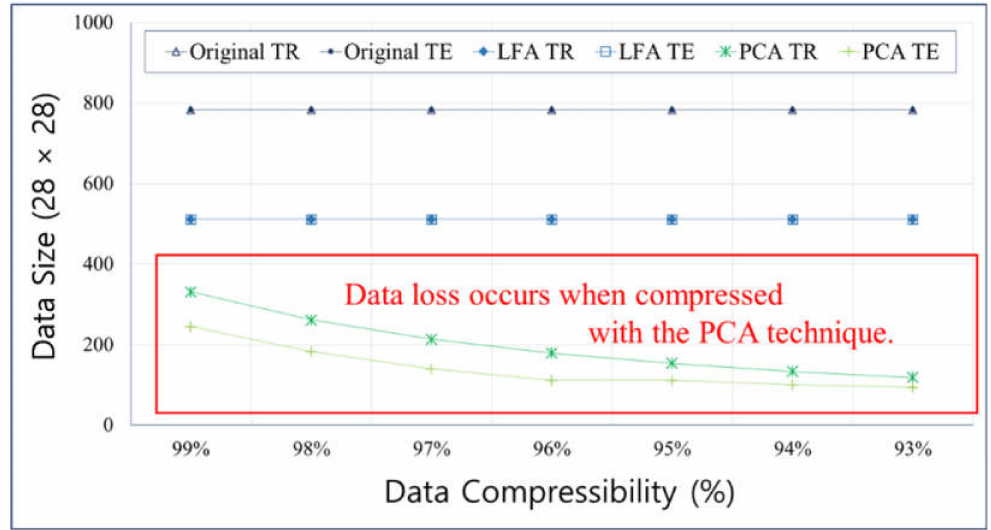
Figure 9. The size of the resulting data according to the compression of the data (TR: training, TE: